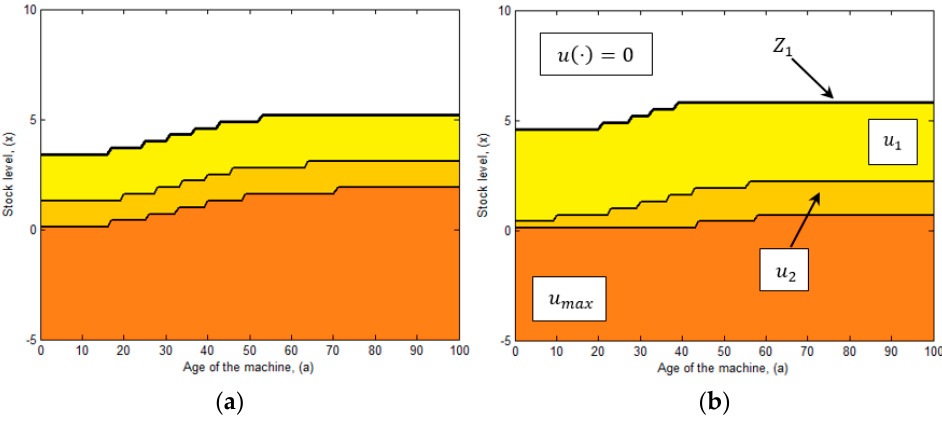
Figure 10. Sensitivity of the defectives cost on the production policy. ( a ) c d = 3; ( b ) c d = 12.